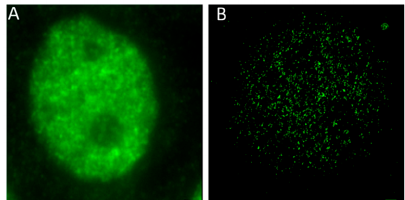
Figure 2. Fluorescence images of MCF-7 cell nuclei after specific labelling of MRE11 by antibodies. ( A ) conventional wide-field image; ( B ) pointillist single-molecule localization microscopy (SMLM) image obtained from the “Orte-Matrix” (scale bar 1 μ m). Typically, about 50,000 points could be separated. Depending on the MRE11 activation state, a “network” like organization of molecules with areas of different concentration was recorded.